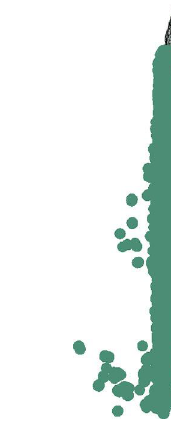
Figure 20: Morphology of the bird body at di ff erent moments of 60 ° .